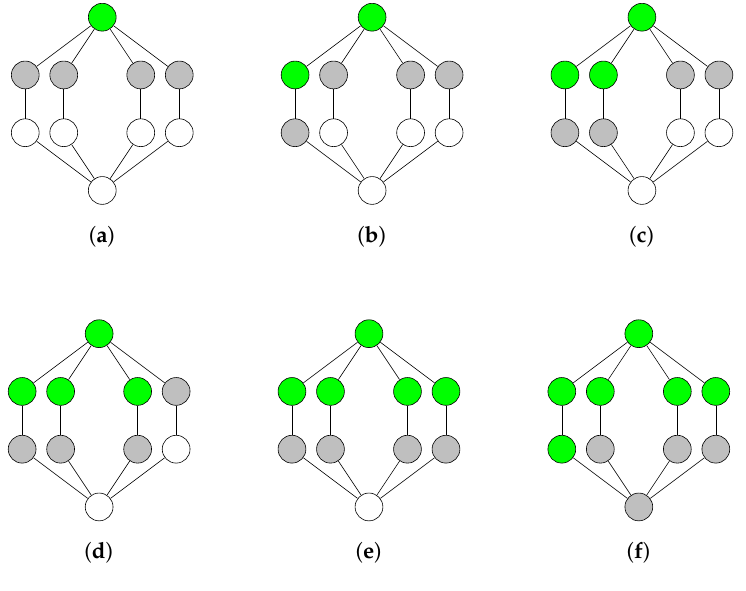
Figure 7. Tree growing algorithm. The dominators are colored in green. The non-dominators that are adjacent to at least one dominator are colored in grey. ( a ) The algorithm arbitrarily chooses a node with the largest number of white neighbors. The chosen node is colored in green and its neighbors are colored in grey. ( b – f ) The algorithm arbitrarily chooses a grey node with the largest number of white neighbors. The chosen node is colored in green and its white neighbors are colored in grey. The algorithm stops in ( f ) because each node is colored in either green or